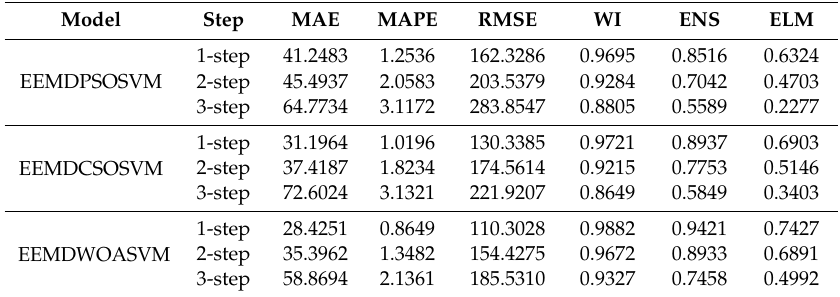
Table 3. Forecasting results of di ff erent models with EEMD using 30 min electric load data from New South